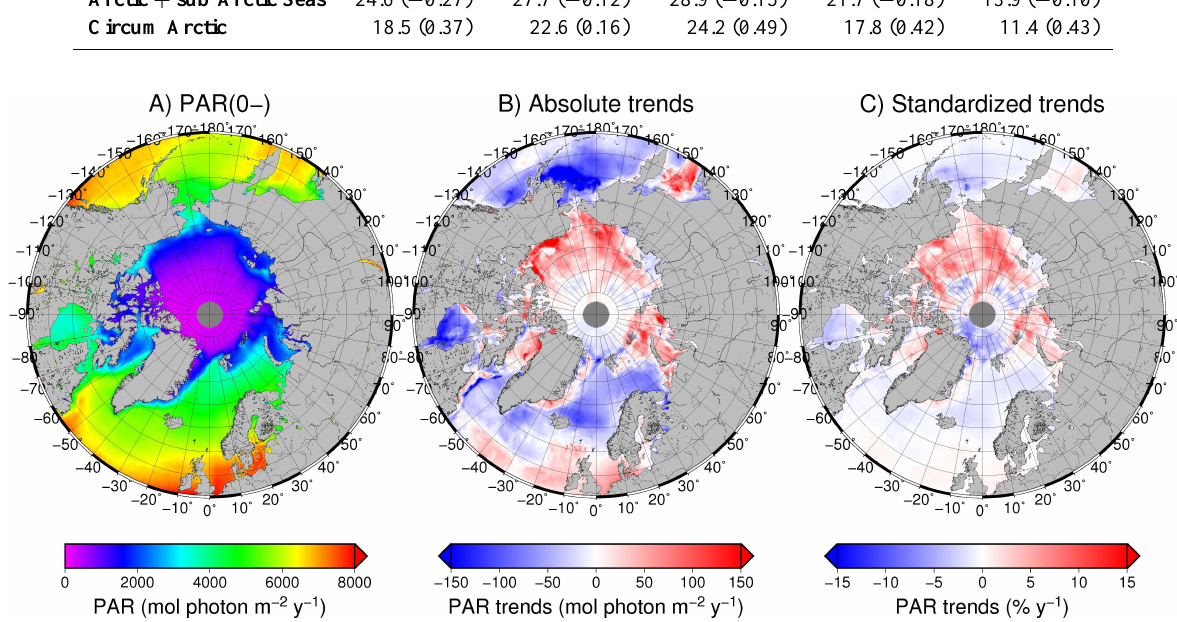
Fig. 2. Same as Fig. 1, but for PAR just below the air-sea interface (PAR(0 −